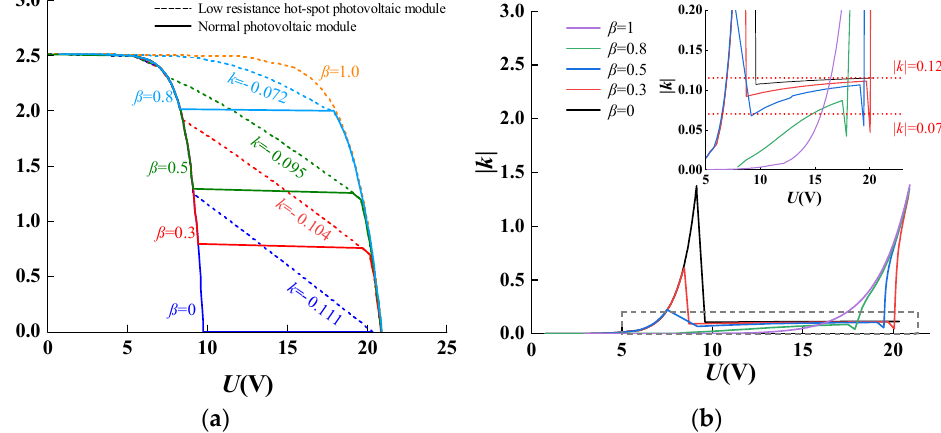
Figure 7. Output characteristic curve of photovoltaic module under different light ratio β . ( a ) Output I-U characteristics; and ( b ) Output | k | value .